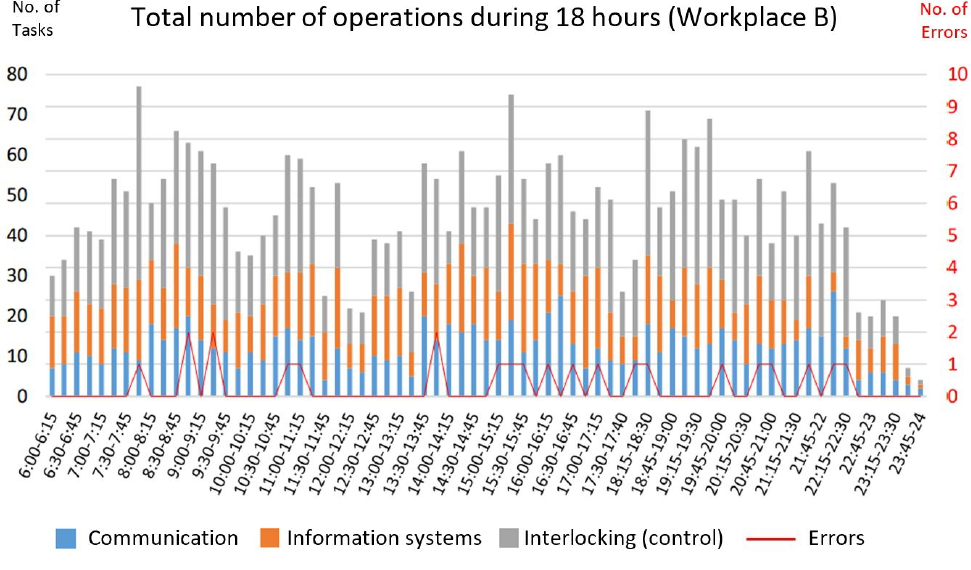
Figure 7. Distribution of operations, tasks and errors over the observed period of 18 h at workplace